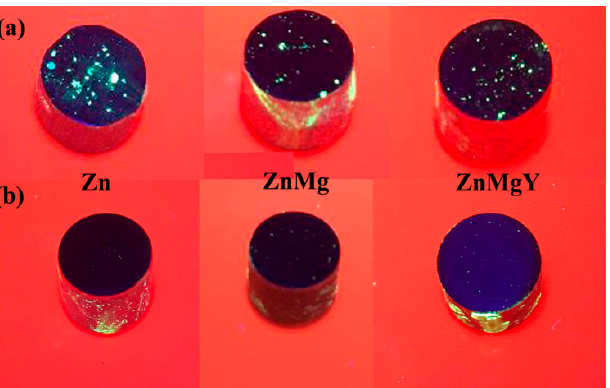
Figure 1. NDT analysis of melted Zn, ZnMg, and ZnMgY alloy ( a ) first melt sand ( b ) after five re-melts.